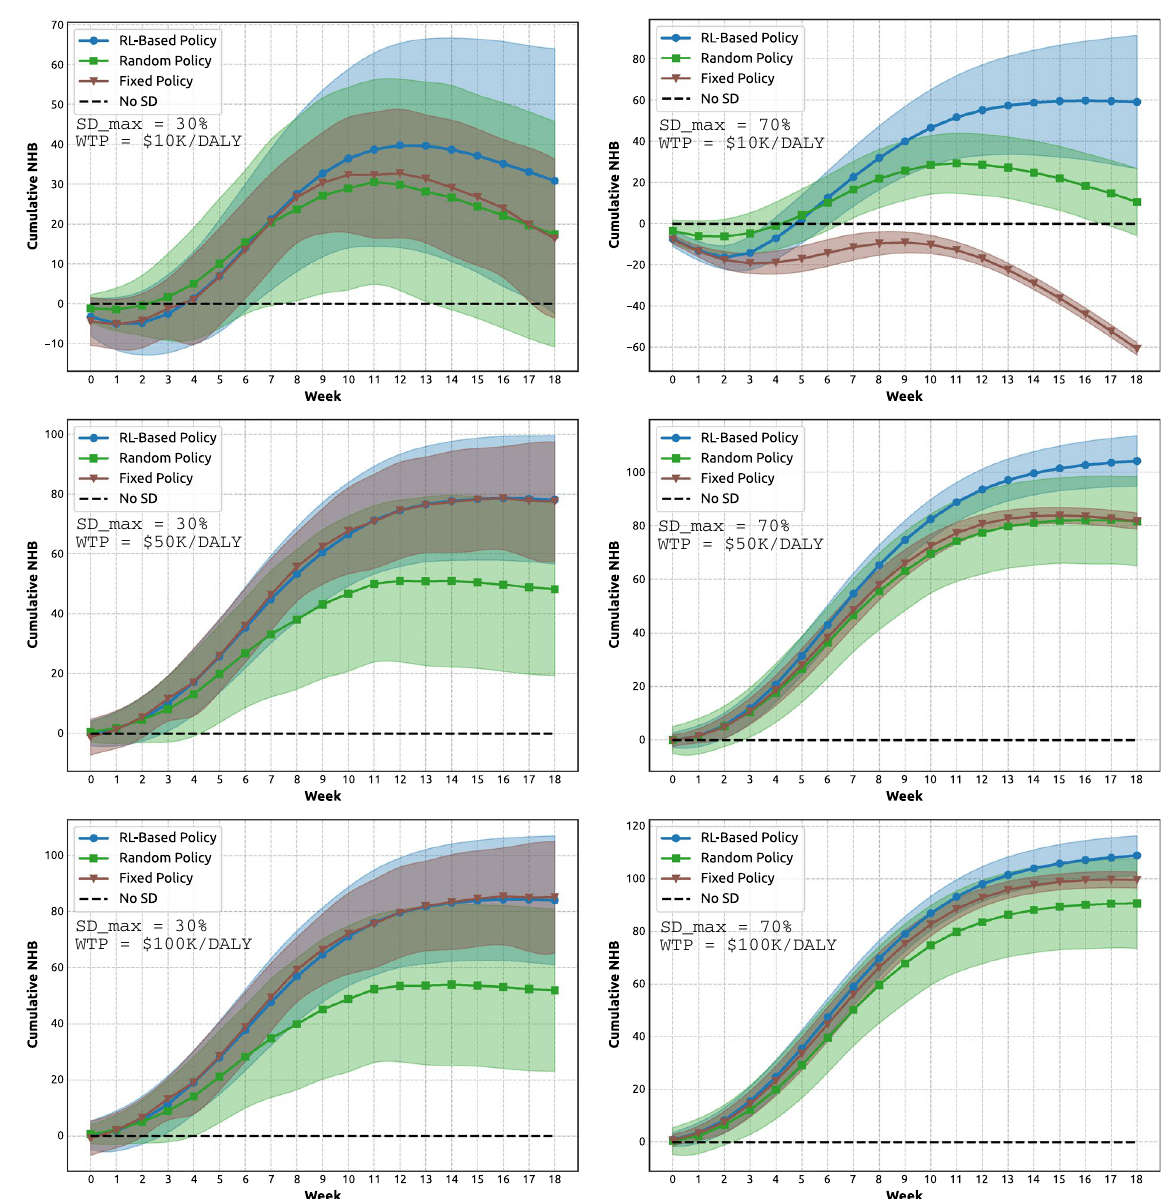
Figure 2. A comparison of cumulative Net health benefit (NHB) generated by the adaptive NPIs, fixed SD NPIs, random SD policies, and zero SD policies. Left: SD max = 0.3 . Right: SD max = 0.7 . Top: WTP is set at $10K per DALY. Middle: WTP is set at $50K per DALY. Bottom: WTP is set at $100K per DALY. Shaded areas show standard